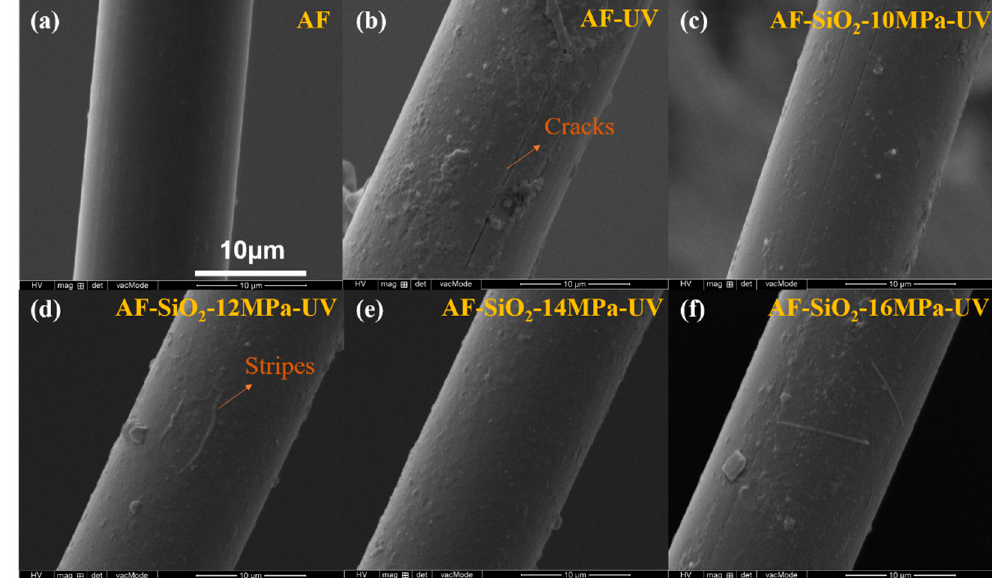
Polymers 2019 , 11 , x FOR PEER REVIEW Figure 11. SEM images of the untreated and irradiated AF. Figure 11. SEM images of the untreated and irradiated AF.